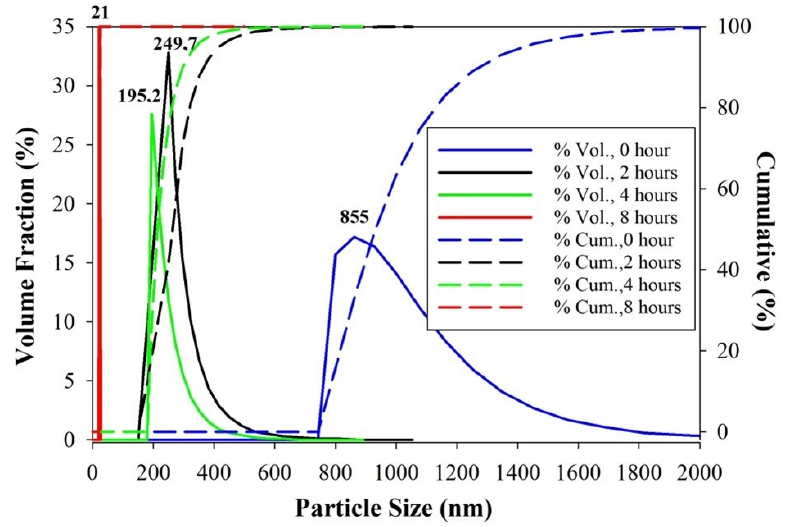
Figure 13. Effect of sonication time on particle size distribution of BaFe 11.2 Mg 0.4 Al 0.4 O 19 .